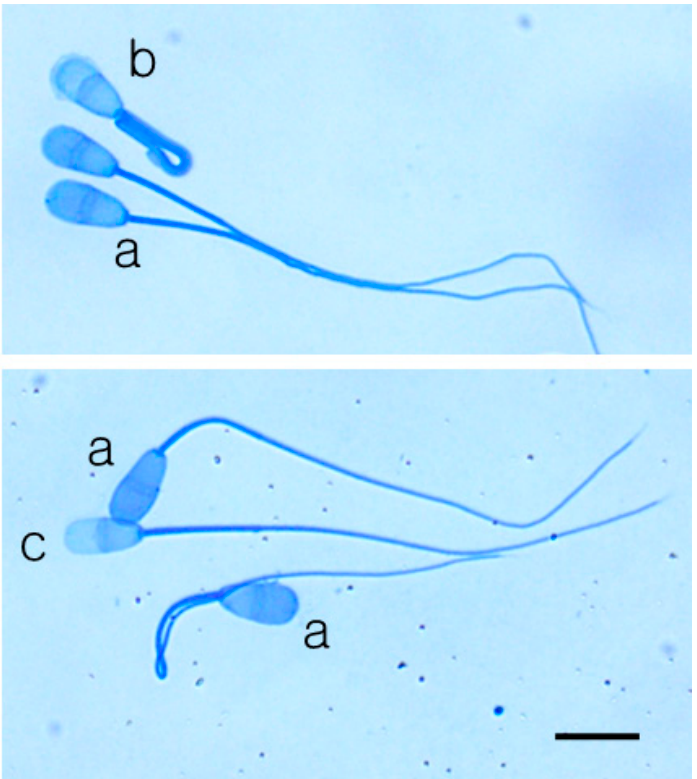
Figure 3. A bovine spermatozoa image stained with a mixed solution of 0.1% coomassie brilliant blue (CBB) R-250 and 0.1% CBB G-250. Spermatozoa with intact acrosomes ( a ) have a bright blue staining pattern over the entire acrosome, whereas damaged spermatozoa have swollen outer membranes ( b ) or no staining pattern over the acrosome ( c ). The black bar is 10 µm.